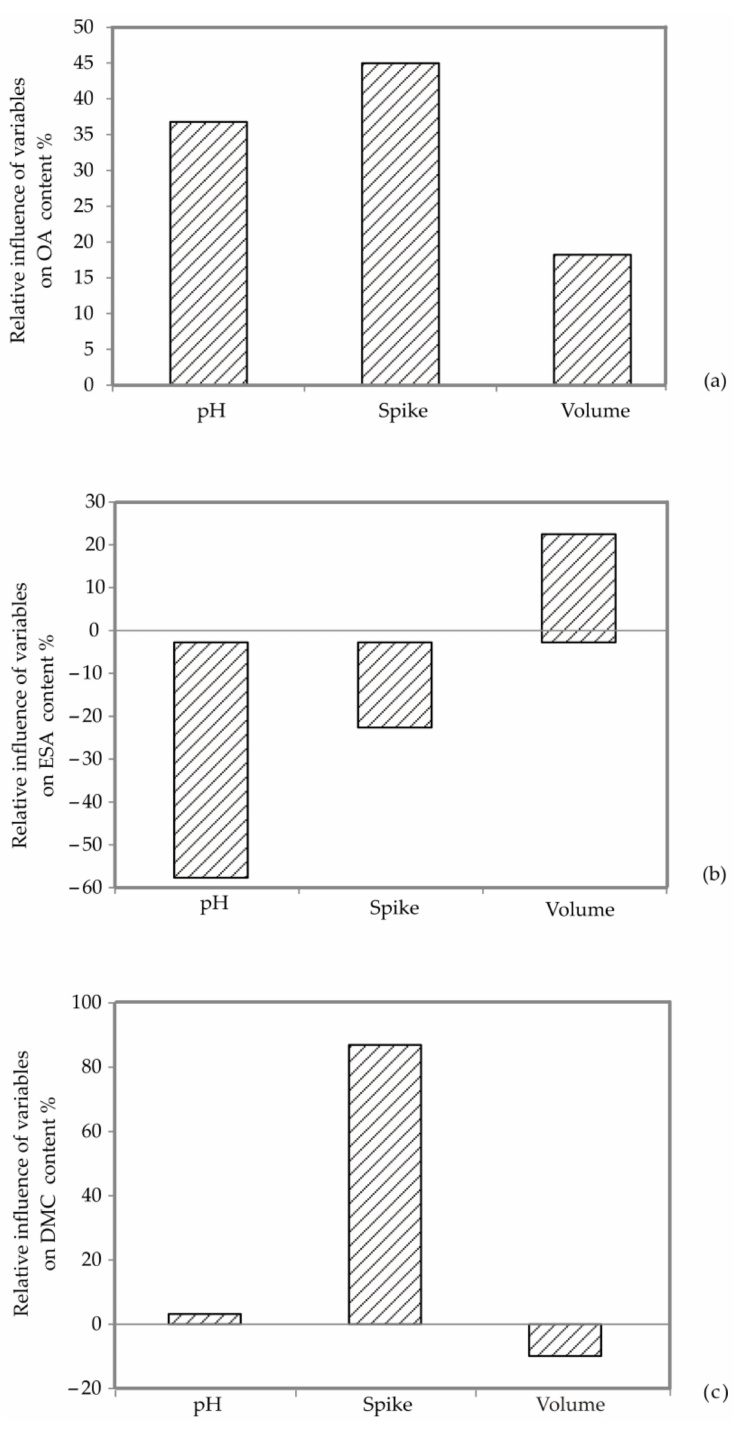
Figure 6. The relative importance of the content of pH, spike and volume on: ( a ) OA, ( b ) ESA, and ( c )